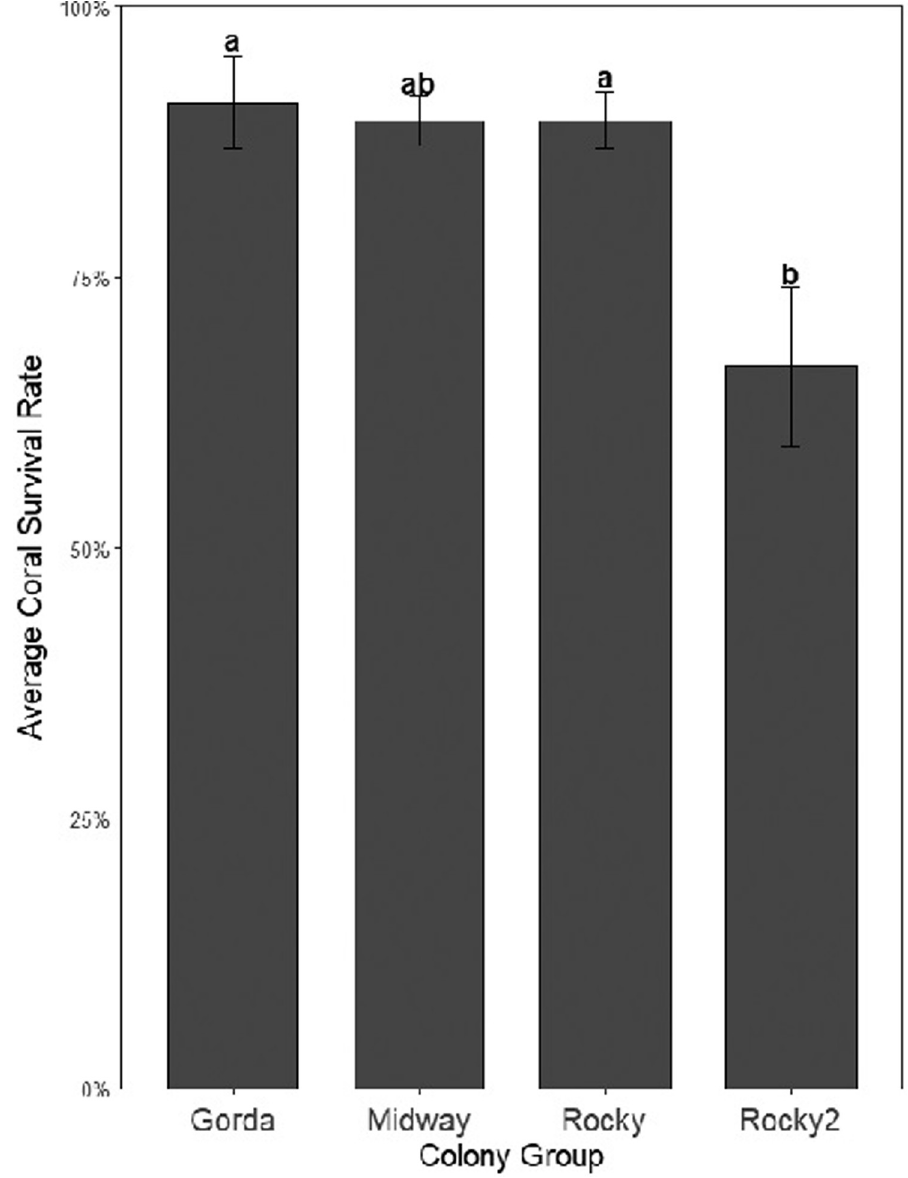
Fig 3. Average ( ± SE) coral survival rate (%) of four Acropora palmata donor colonies grown on horizontal line nurseries, Abaco, Bahamas after three years. Letters group the average coral survival rate in which statistically significant differences occurred ( p <